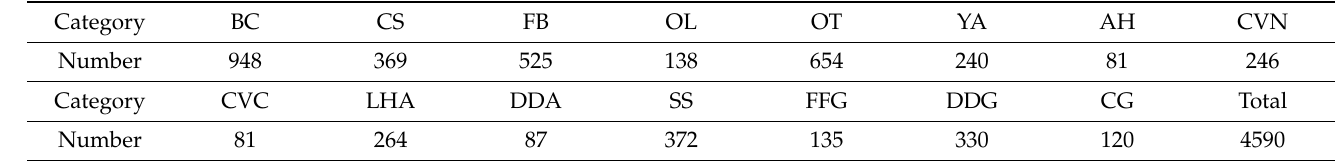
Table 2. Number of images in each category in the ORCS-15 dataset. The total number of ORSC-15 dataset is